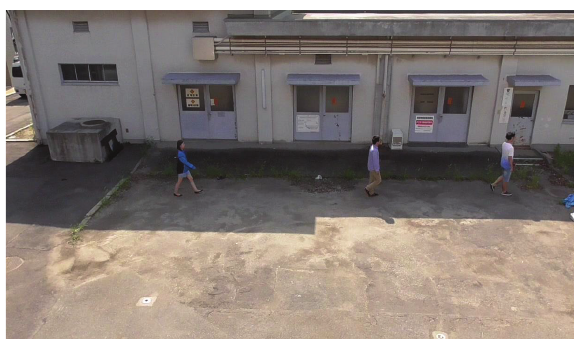
Figure 6: Location 2.